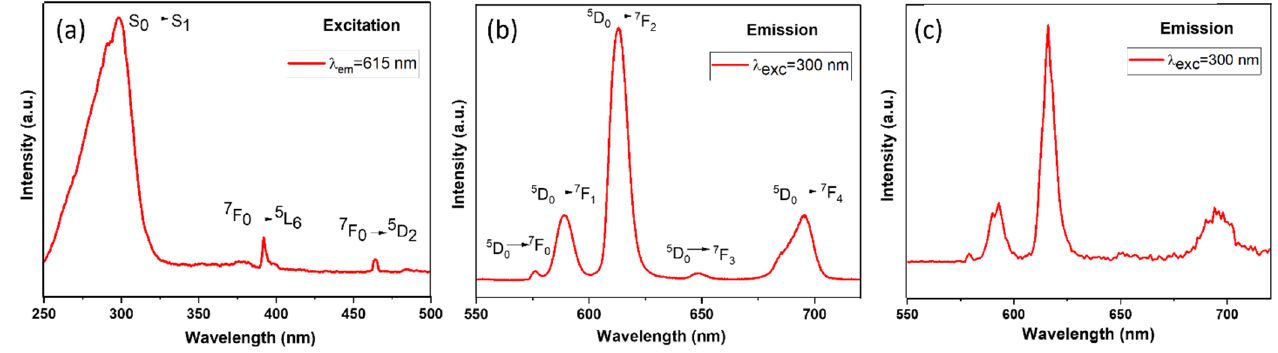
Table 2. Experimental luminescence parameters. Experimental Nonradiative (A nrad ), Radiative (A rad ) Decay Rates; Intensity Parameters Ω 2 and Ω 4 ; Quantum Efficiency ( η ) and lifetime ( τ